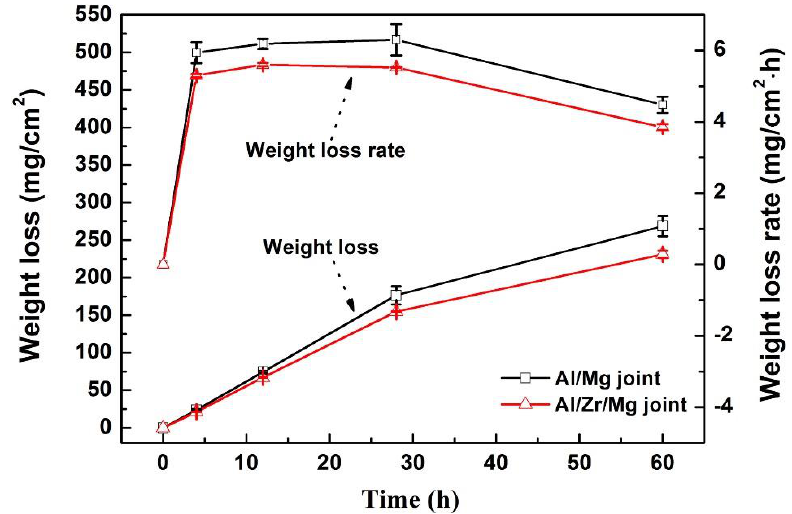
Figure 13. Weight losses and corresponding change rates of the Al/Mg and Al/Zr/Mg joints during the immersion tests in the 3.5% NaCl solution for 60 h.